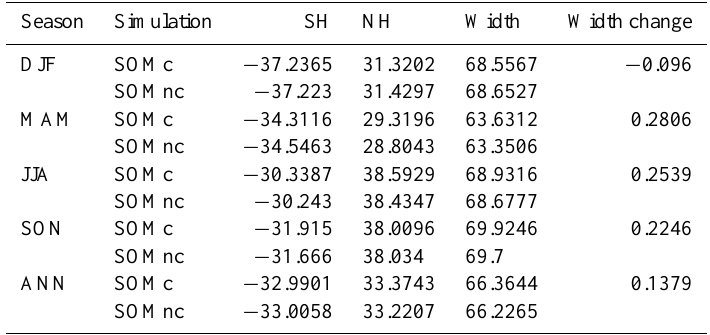
Table 4. The SH and NH latitudes of zero meridional mass flux at 500hPa, the width of the Hadley cell, and change of the width between control and no-carbon runs. Results are from the SOM runs.